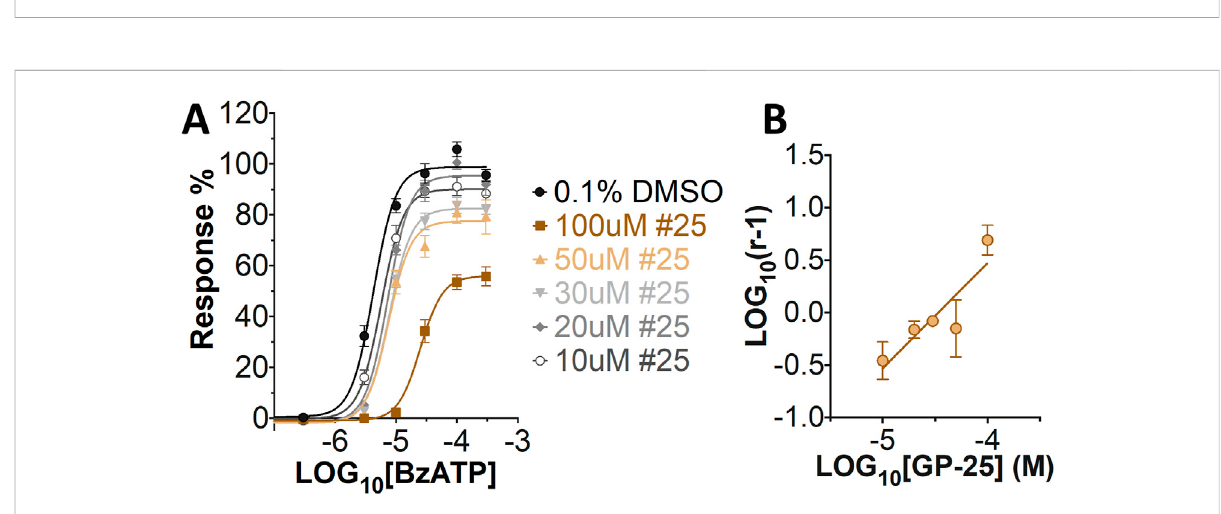
FIGURE 2 Functional characterization of GP-25. (A) ATP concentration-response curves(YoPro-1 assay)for human P2X7 (black line, circles)andratP2X7(grey line, triangles). Estimated EC 50 valueswere 183.5 and 138.3 µM for human and rat P2X7, respectively. (B) GP-25 concentration-inhibition curves (YoPro-1 assay) for human P2X7 (brown line, circles) and rat P2X7 (black line, triangles) (300 µM ATP). Estimated IC 50 values were 8.7 μ M at human P2X7 and 24.4 μ Mat rat P2X7. (C) Representative traces for human P2X7 showing inhibition of ATP-evoked currents by GP-25 (concentrations indicated) in whole-cell patch clamp. (D) Summary of GP-25 inhibition data from YoPro-1 (left) and patch clamp (right) experiments.*; p ≤ .05(One-way ANOVA). ns; non-signi fi cant. YoPro-1 assay data represents two independent experiments ( n = 3 – 5 each); electrophysiology n = 5 – 7 for each GP-25